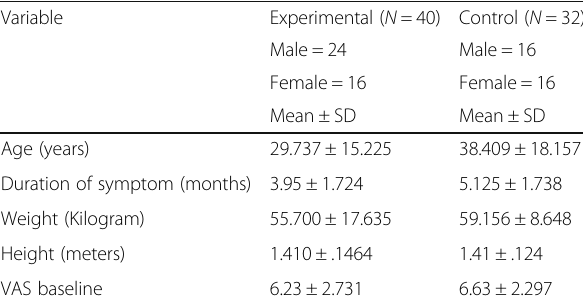
Table 1 Baseline characteristics of the groups evaluated at initial